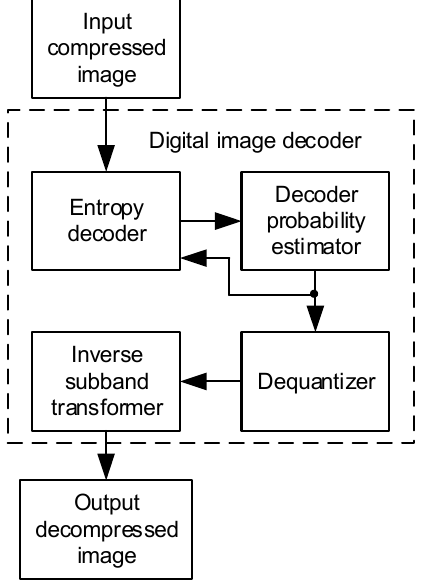
Figure 1. The block diagram of the state ‐ of ‐ the ‐ art digital image decoder.